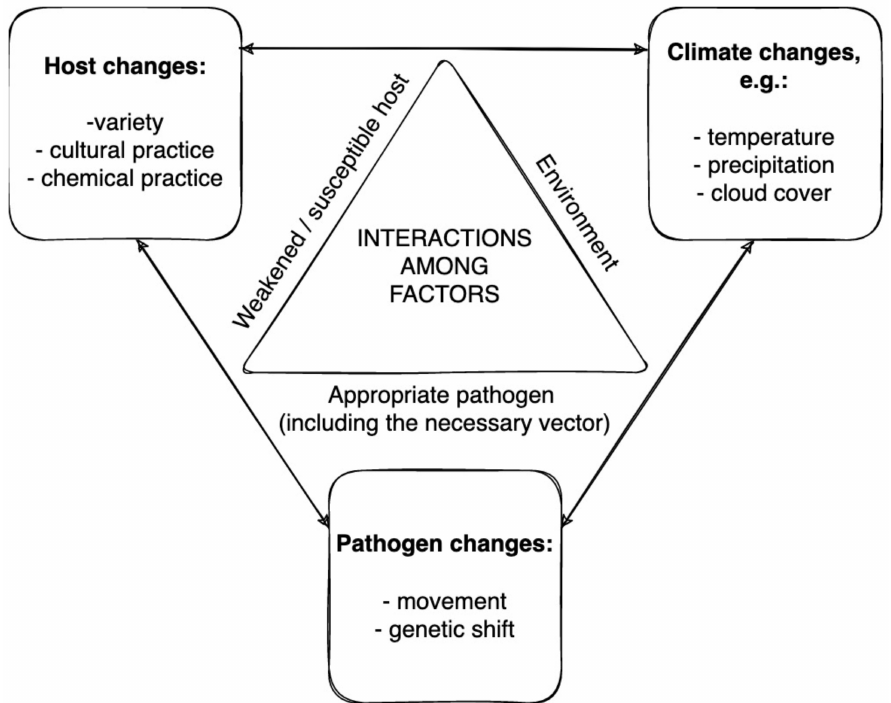
Figure 5. Climatic features such as temperature and humidity are important factors in disease. Plant disease consists of three interdependent factors: the host, the pathogen (often with a vector), and the environment. The number of diseases is closely related to changes in these